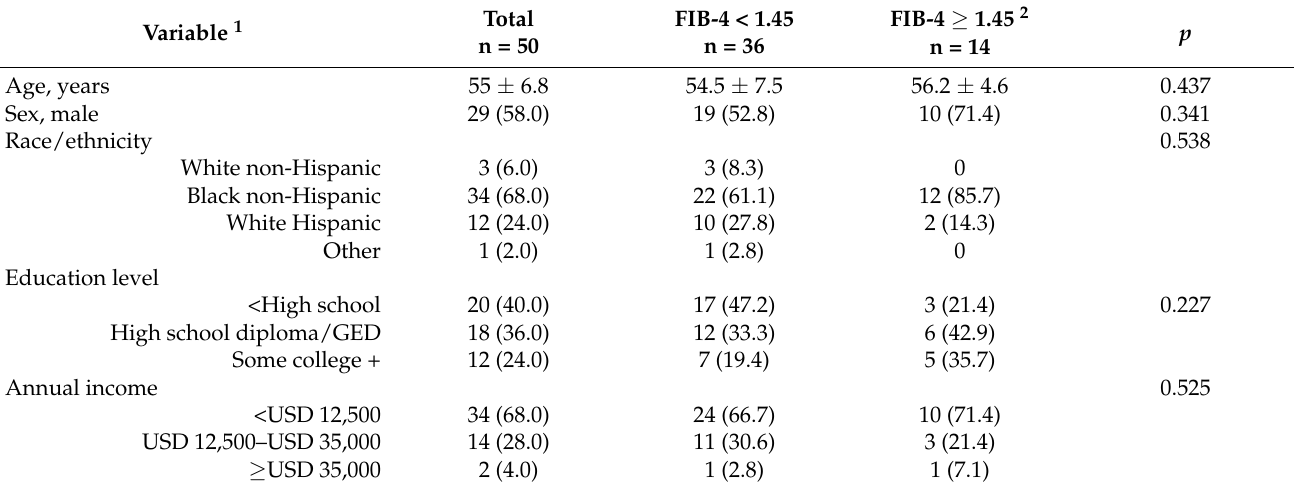
Table 1. Characteristics of Study